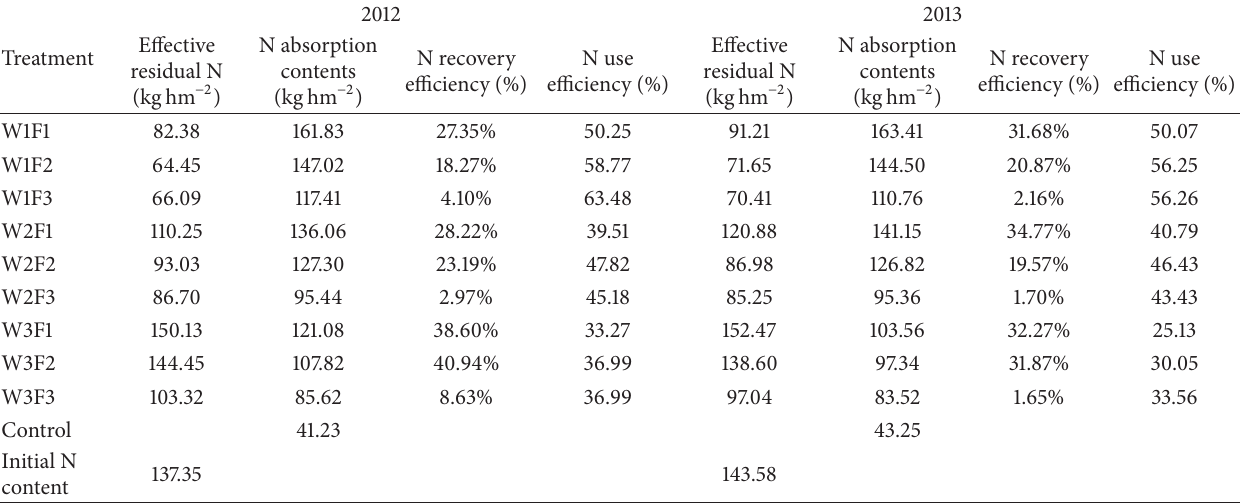
Table 3: The fertilizer N recovery efficiency and use efficiency were after harvest in two consecutive years.